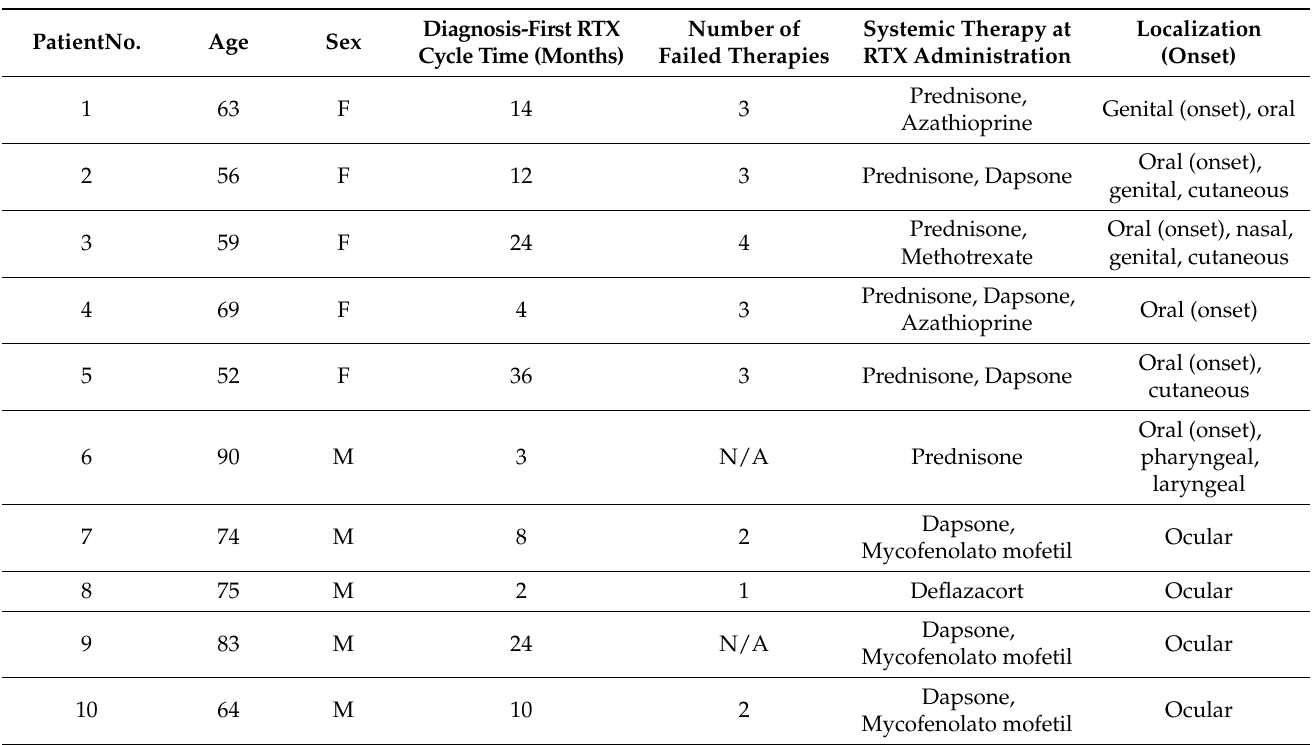
Table 1. Patient